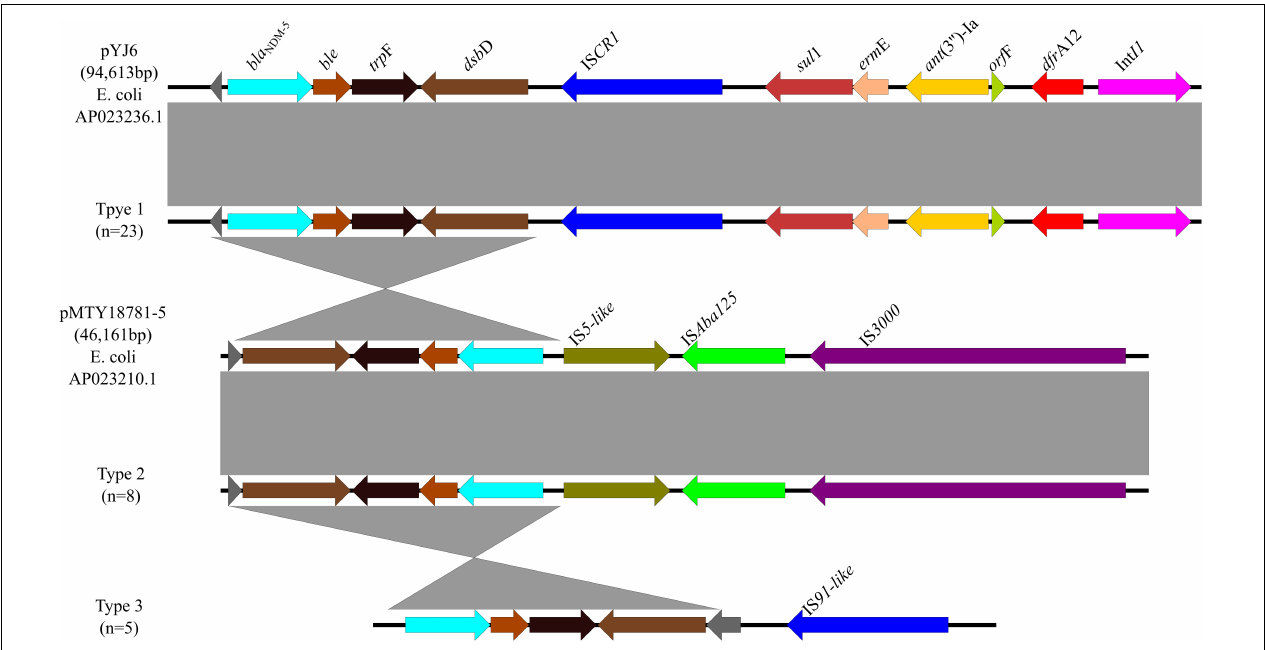
FIGURE 6 | Genetic environments of bla NDM − 5 in plasmids. Arrows indicate the direction of transcription of the genes, and different colors indicate different genes. Regions of ≥ 99.0% nucleotide sequence identity are shaded gray.